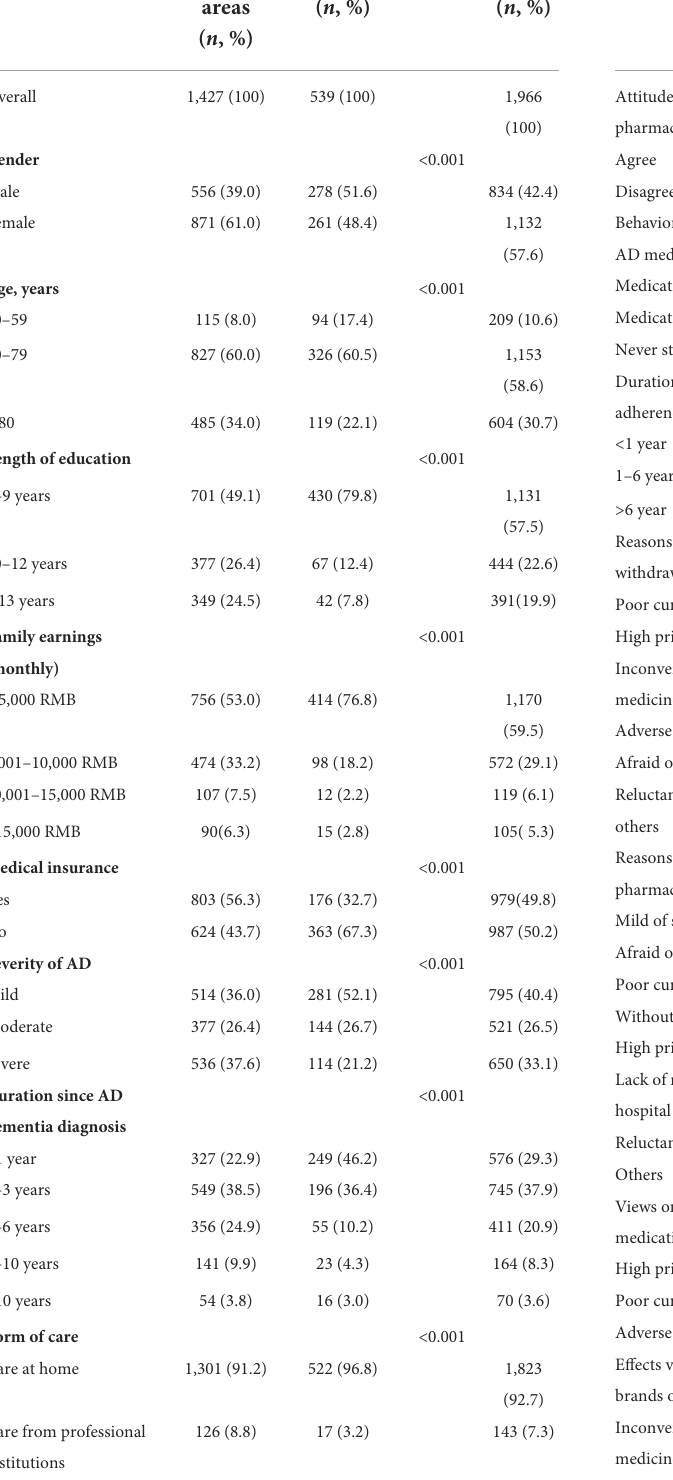
TABLE 1 The demographic and clinical characteristics of the urban and rural people with AD.